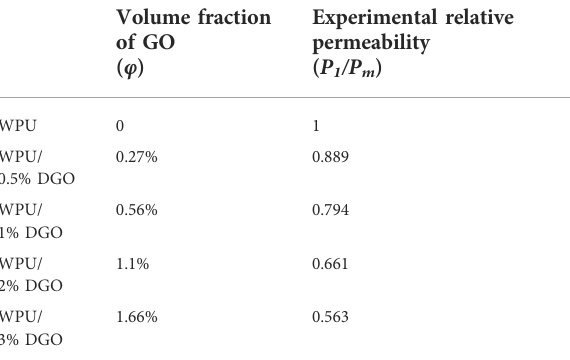
TABLE3Govolumefractionandexperimentalrelativepermeabilityby calculation.